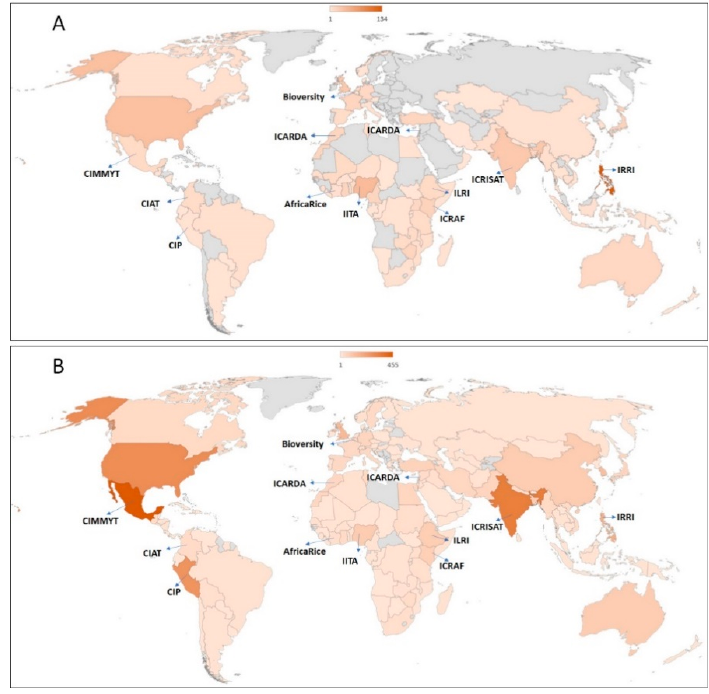
Figure 3. Countries from which the CGIAR centers received germplasm ( A ), and countries that received germplasm from the CGIAR centers ( B ) in 2018–19. The data combine transfers from the genebanks and crop breeding programs. The intensity of the orange shade indicates the number of transfer instances.